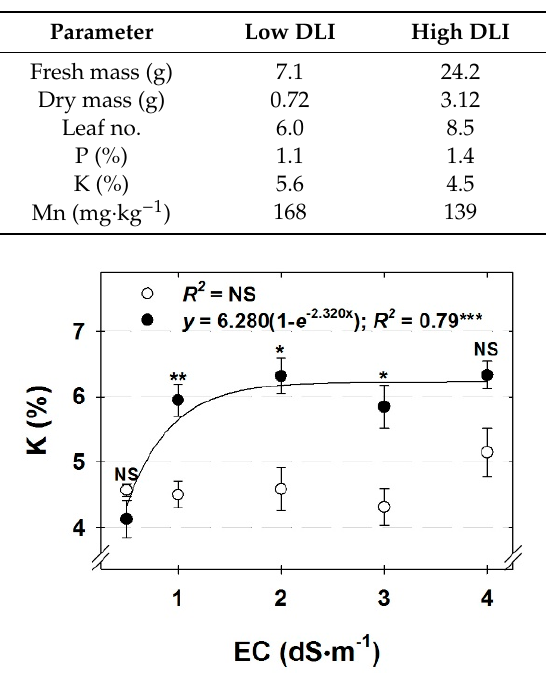
Figure 2. Tissue K of dill ( Anethum graveolens ‘Fernleaf’) 4 weeks after transplanting into nutrient-film technique hydroponic systems in a greenhouse under a low (~7 mol · m − 2 · d − 1 ; closed symbol) or high (~18 mol · m − 2 · d − 1 ; open symbol) daily light integral (DLI) with a range of nutrient solution electrical conductivity (EC; 0.5 to 4.0 dS · m − 1 ) treatments. Each symbol represents the mean of three replications with ten plants per replicate, and error bars represent the standard errors of the mean of the three replicates. NS, *, ** or *** indicate non-significant or significant at p ≤ 0.05, 0.01, or 0.001, respectively.